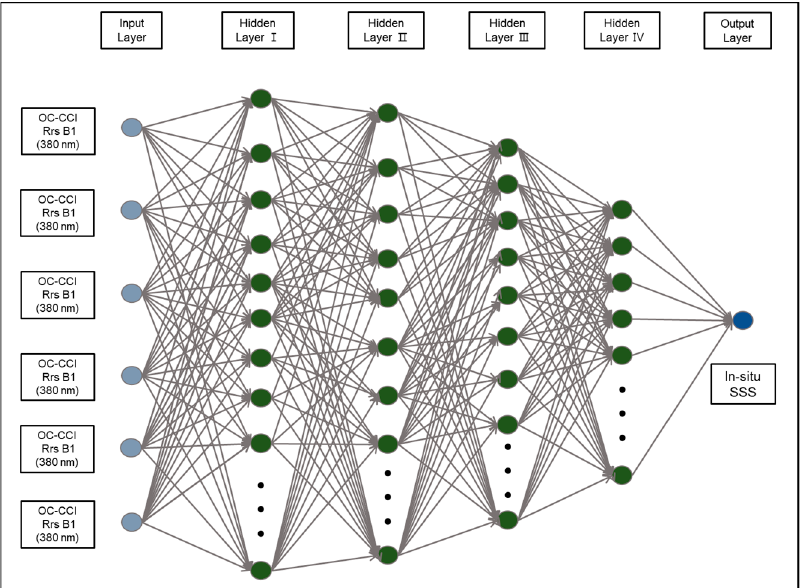
Figure 2. The MPNN model architecture based on the OC-CCI Rrs six bands data and KNIFS serial shipboard measurements. Among the 2421 datasets, 80% were used to train, and 20% were used to validate model. The input datasets were fixed, and the number of hidden layers and neurons in hidden layers were varied to derive the best performance.